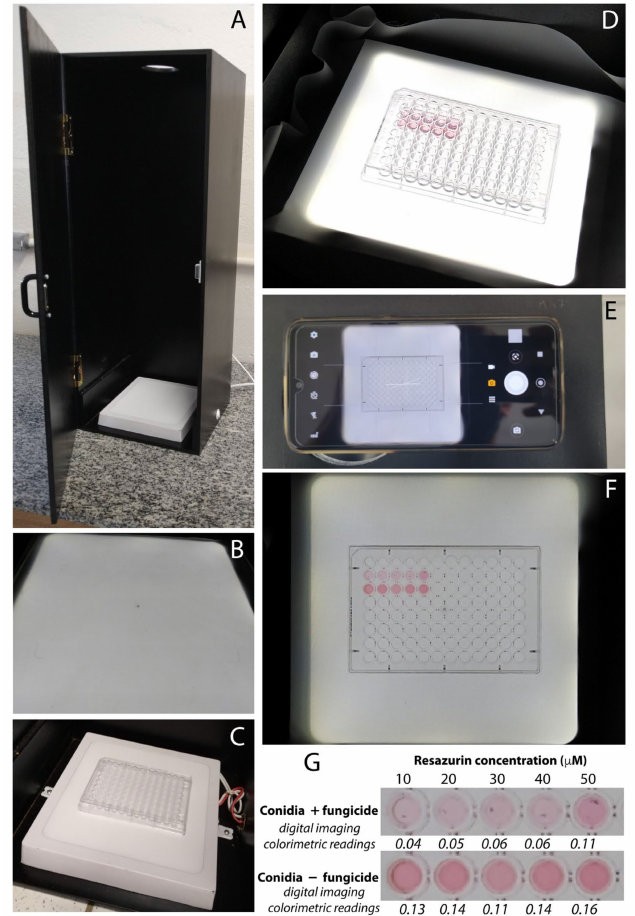
Figure 1. ( A ) Handmade transilluminator for the colorimetric resazurin-based digital-imaging assay (COL-assay) developed by our group for this study. ( B ) Photography diffuser film covering square